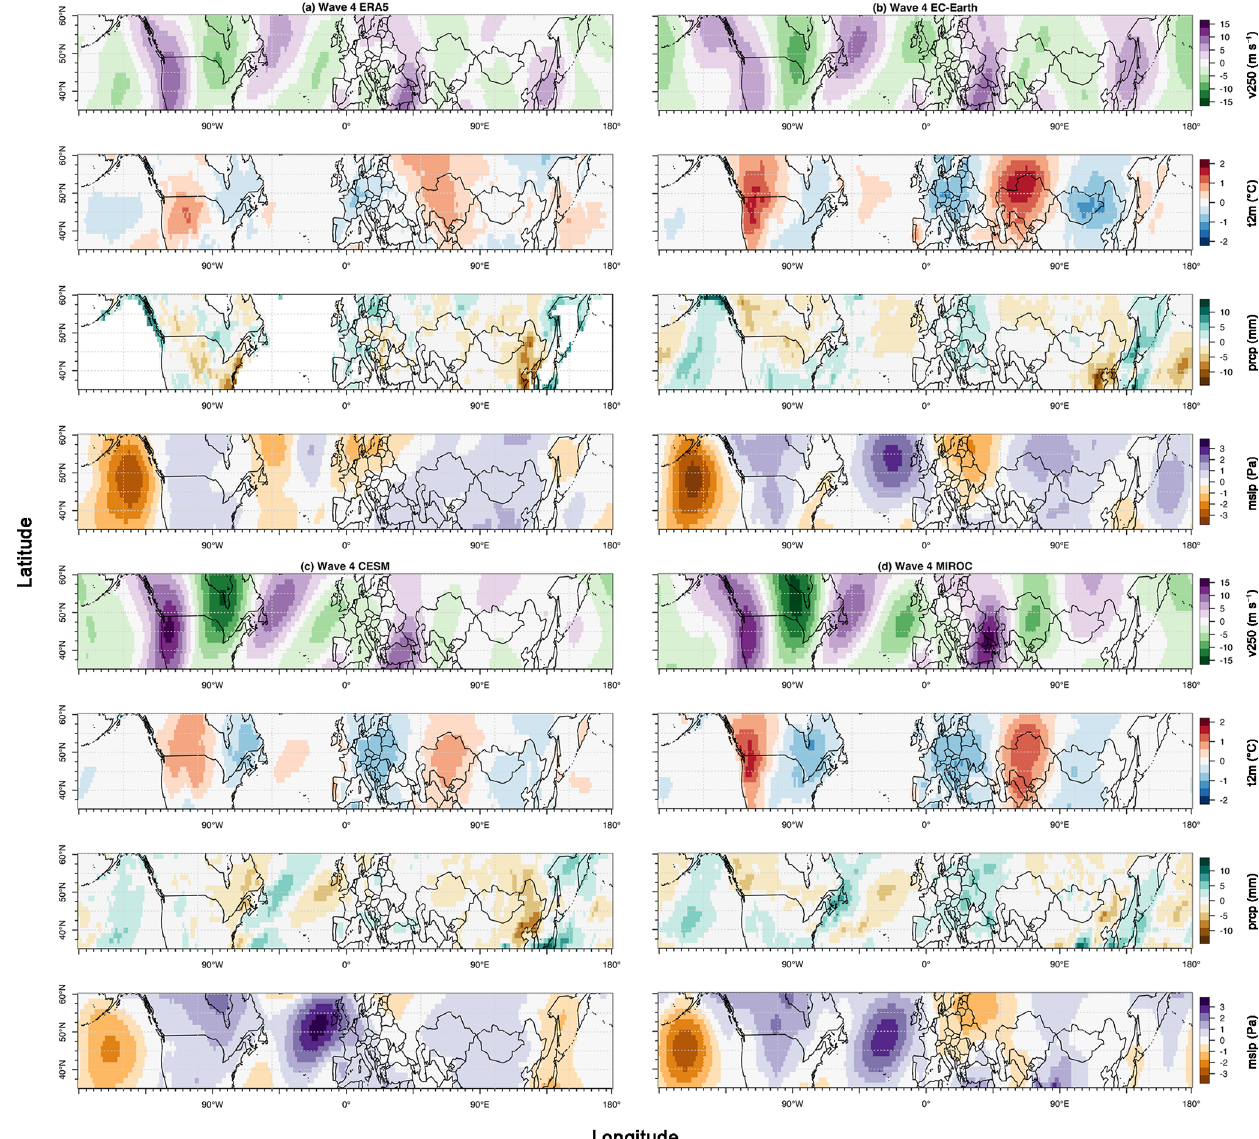
Figure B3. Composite anomaly plots of weeks with high-amplitude wave-4 episodes for meridional wind velocity at 250hPa (v250, absolute field), near-surface temperature (t2m, anomaly), precipitation (prcp, anomaly), and sea level pressure (mslp, anomaly) in ERA5 (a) , EC- Earth (b) , CESM (c) , and MIROC (d) based on the AISI control runs.